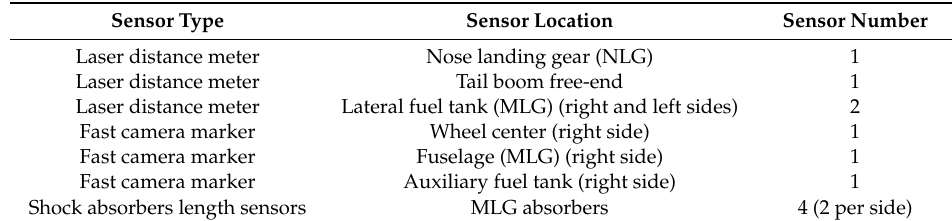
Table 2. Dynamic response sensors.